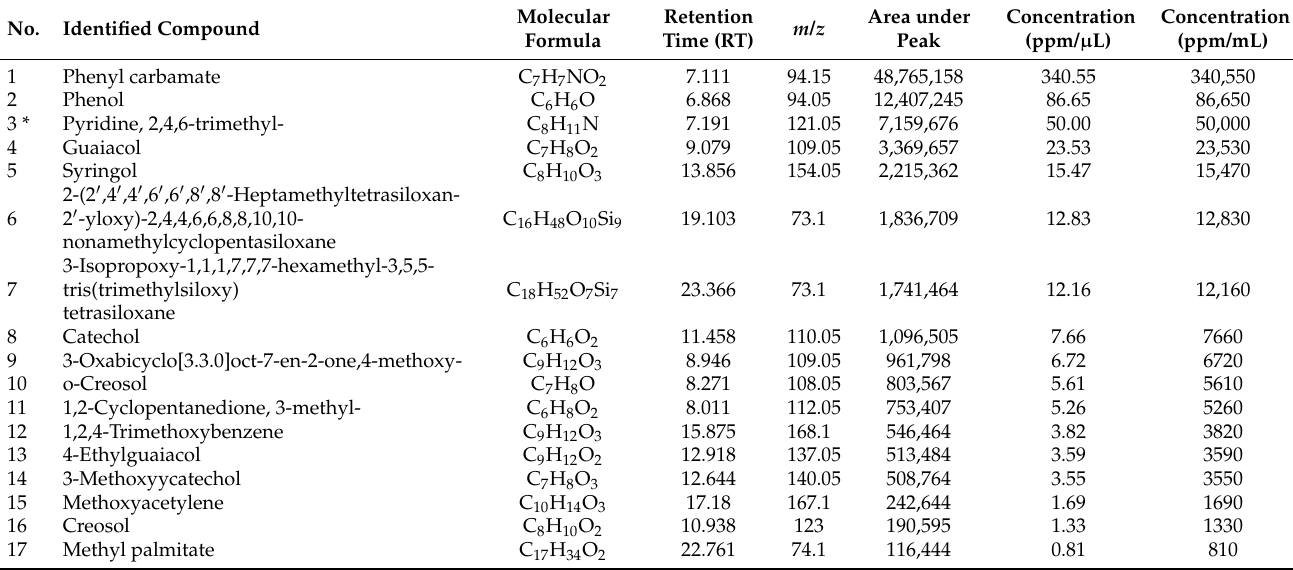
Table 1. GC-MS analysis of oil palm wood